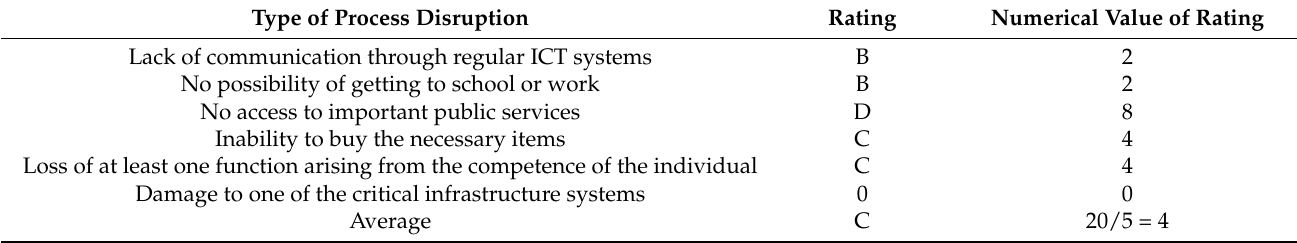
Table 9. Estimating everyday life disruptions for the Bra´nszczyk commune.